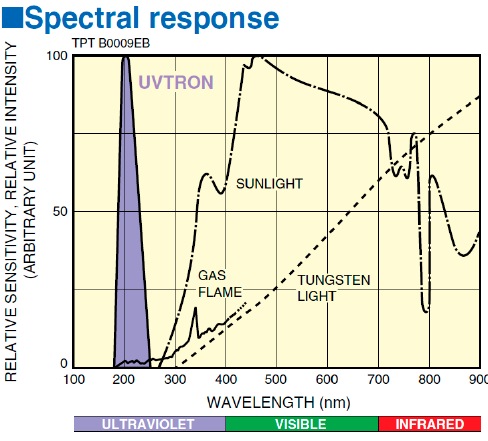
Figure 3 . Spectral response of UVTron in comparison to sunlight, tungsten light, and gas flame